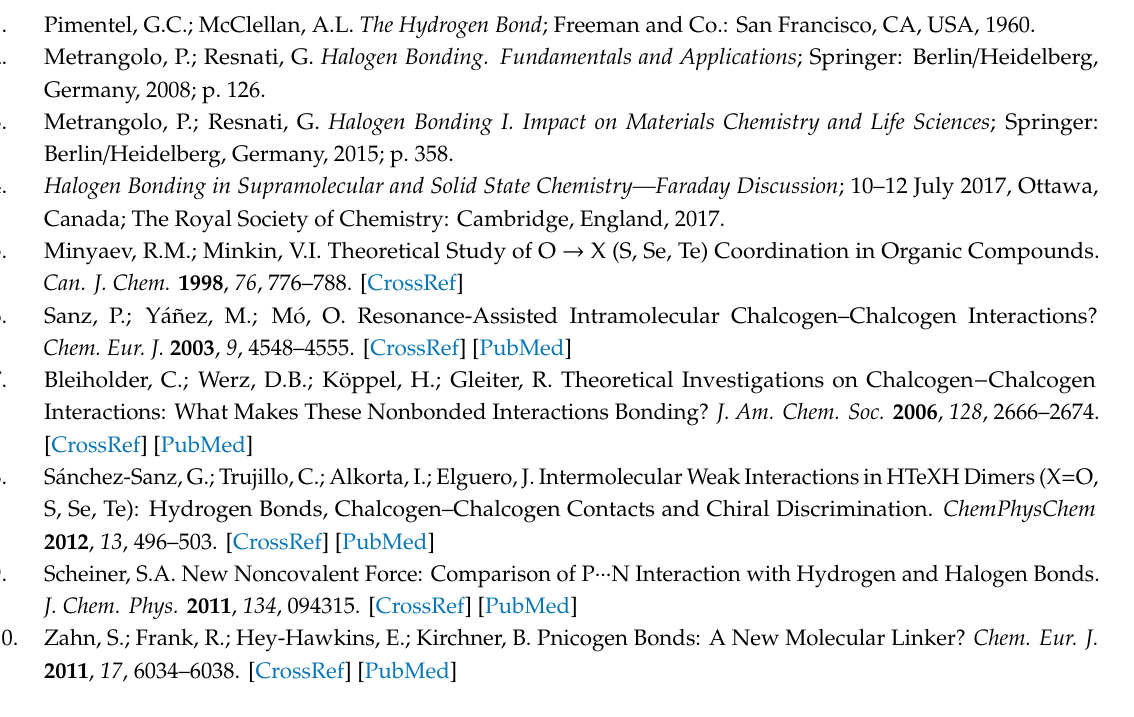
molecular graphs of HN(CH)SX:SCO complexes with C 1 symmetry, Table S2: Structures (Å), total energies (a.u.) and molecular graphs of HN(CH)SX:SCO complexes with C s symmetry, Table S3: Structures (Å), total energies (a.u.) and molecular graphs of HN(CH)SX:SCO molecules, Table S4: Structures (Å), total energies (a.u.) and molecular graphs of HN(CH)SX:SCO transition structures, Table S5: PSO, DSO, FC, and SD components of 1t J(N-C) and 1c J(S-S) for complexes, bound molecules, and transition structures with C s